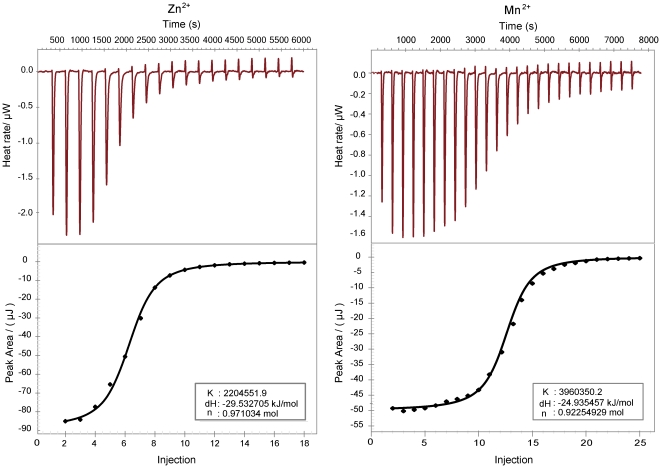
ITC analysis of the SsTroA interaction with Zn and Mn.Left: apo-SsTroA (90 µM) with addition of Zn2+ (500 µM); Right: apo-SsTroA (30 µM) with Mn2+ (200 µM). In each case, the upper panel shows raw energy changes during the titration, while the lower panel presents the integrated peak areas. The fitting of the data yielded the thermodynamic parameters listed in Table S2.